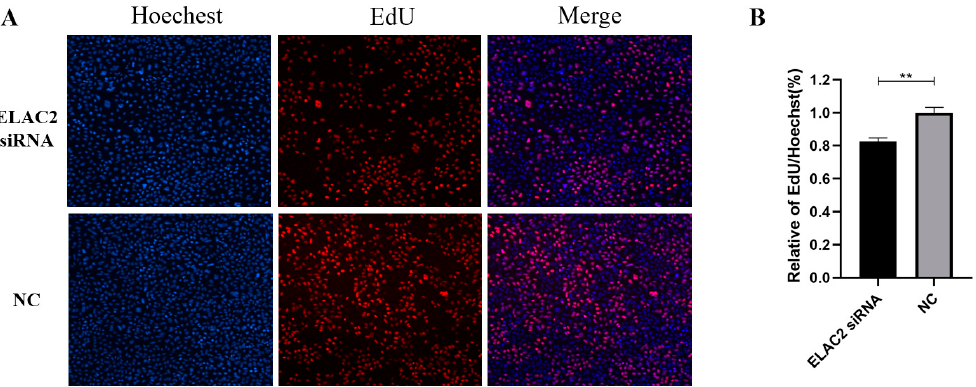
Figure 8. Downregulation of ELAC2 interfere with cell proliferation in HTR-8/Svneo. ( A ) Represen- tative image of EdU staining assay. ( B ) Comparison of EdU signals in si-ELAC2 and control group. ** p < 0.01.